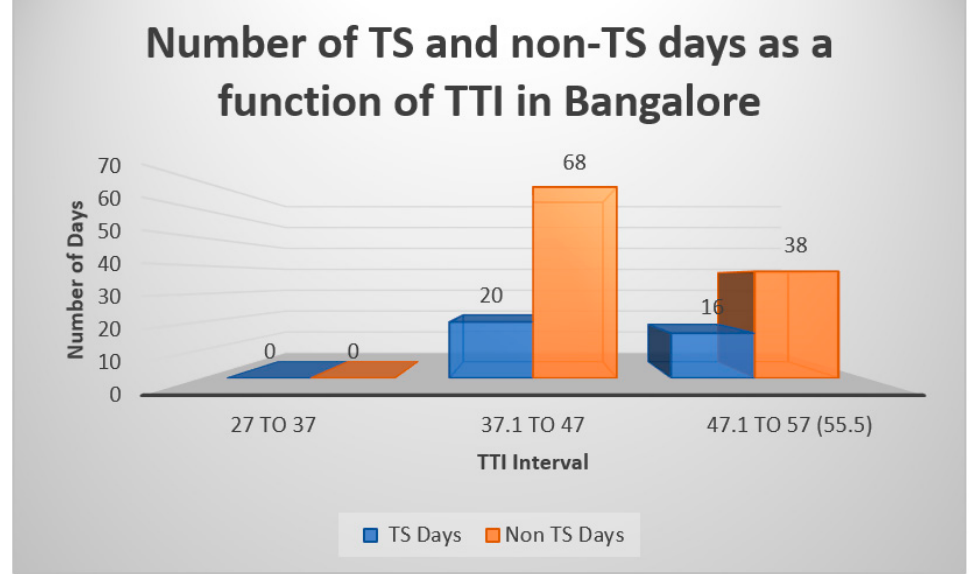
Figure 2. Distribution of thunderstorm and Non-thunderstorm days for given TTI values at 00:00 UTC values over Bangalore.